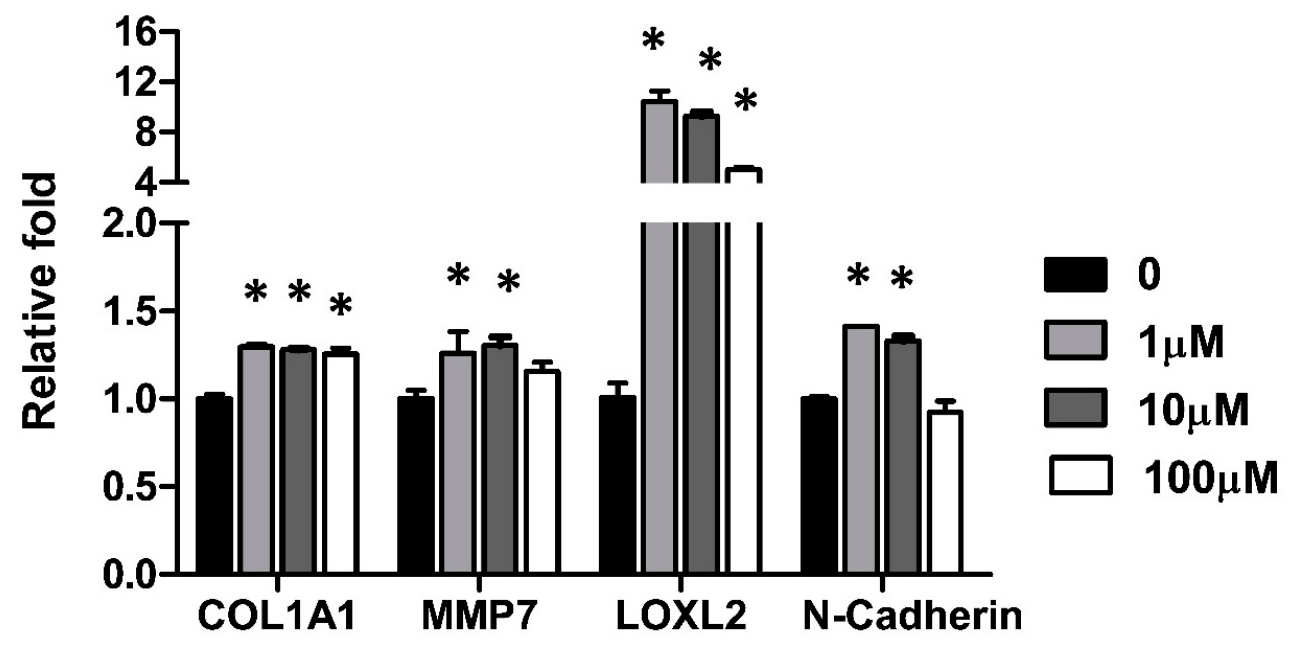
Figure 2. CuSO 4 induced fibrosis-related gene expressions. A549 cells were treated with various doses of CuSO 4 for 48 h and the gene expressions were analyzed by quantitative real-time PCR. The data were expressed as Mean ± SEM, * p < 0.05. The experiment was performed three times for quantification analysis.